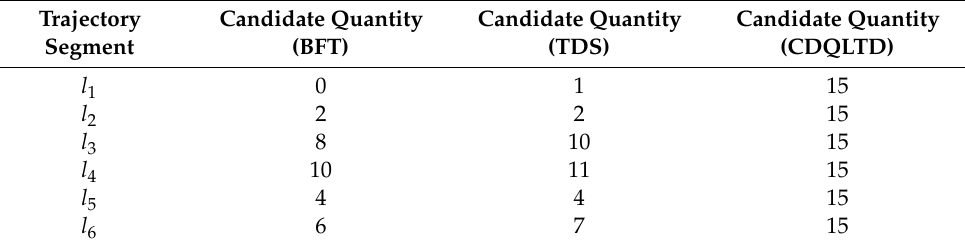
Table 2. Comparison of pruning results.